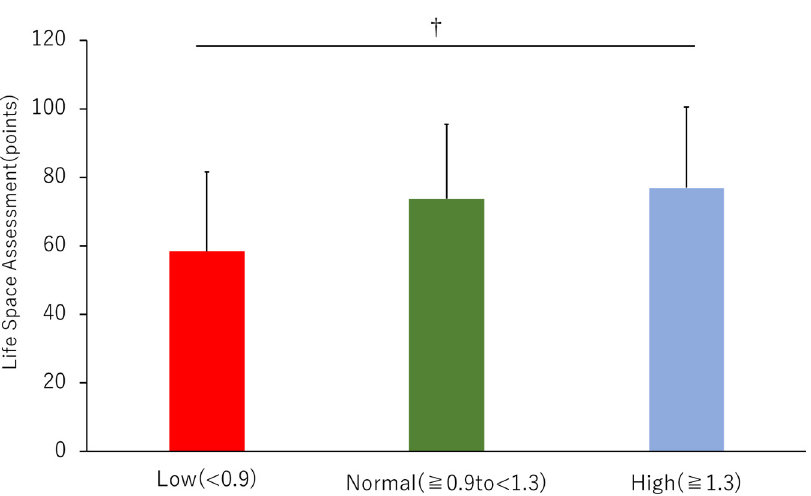
Figure 2. Comparison of life-space assessment by ankle-brachial index (ABI). Red bars indicate an ABI < 0.9, green bars indicate an ABI ≥ 0.9, but <1.3, and blue bars indicate an ABI ≥ 1.3, adjusted for age and patient characteristics to show statistically significant differences in analysis of covariance (ANCOVA). †, vs. High group; p < 0.05. Table 2. Multiple regression analysis for LSA and ADL difficulty.